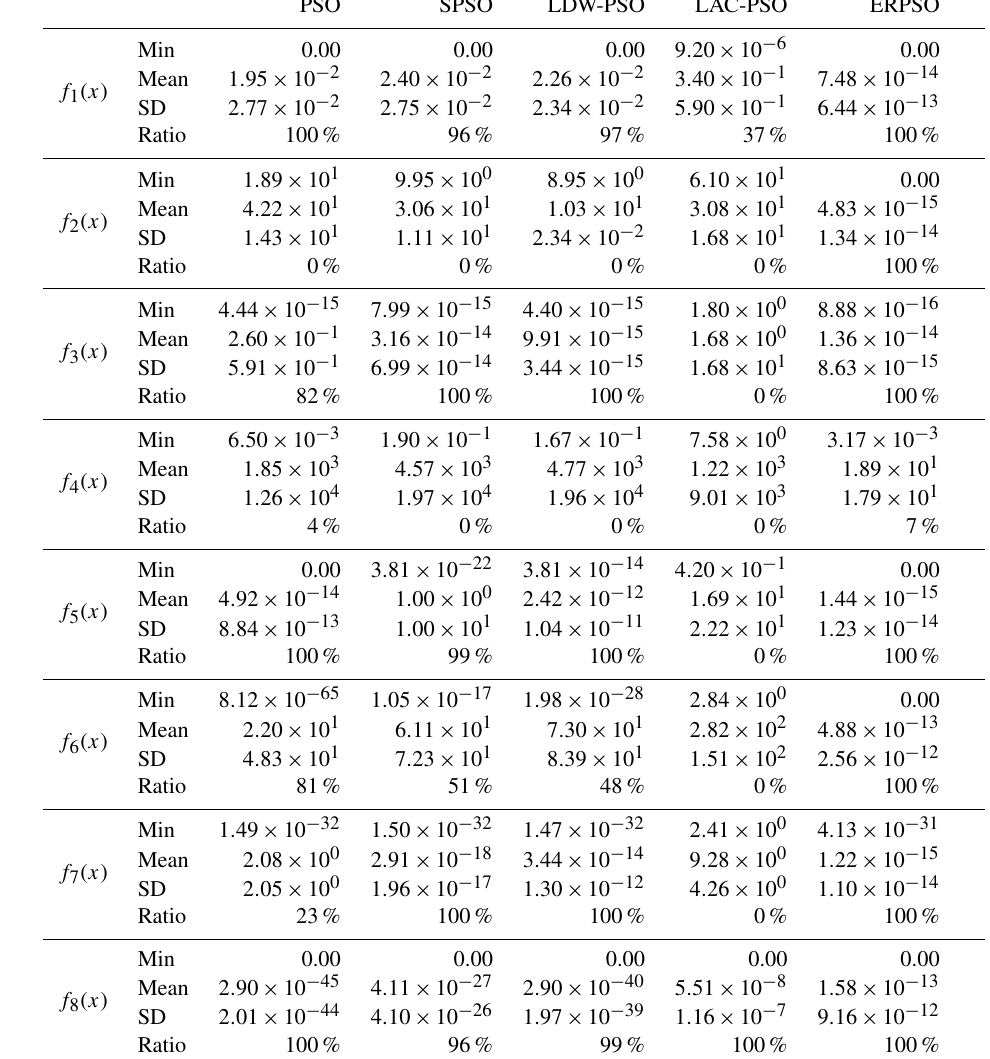
Table 3. Comparison of different PSO algorithms on six optimization BMFs.